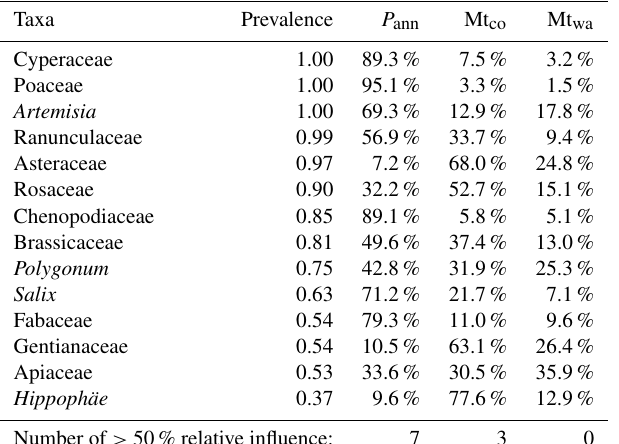
Table 3. Relative influence of climatic variables to the spatial dis- tributions of 14 pollen taxa based on boosted regression tree (BRT) models. For each variable, the relative influence is expressed as a percentage among the three variables. Pollen taxa are ordered by decreasing prevalence (the proportion of sites in which each taxon is present).